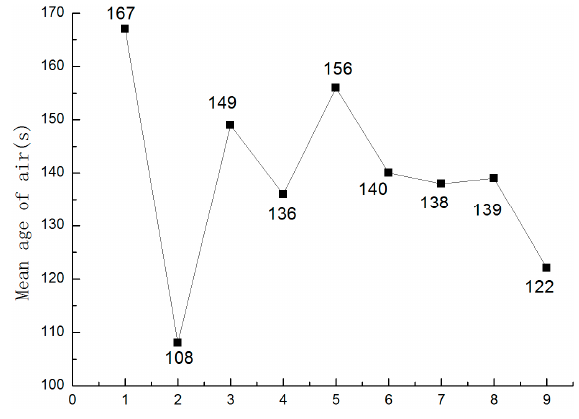
Figure 9. Comparison of age of air in nine tests.